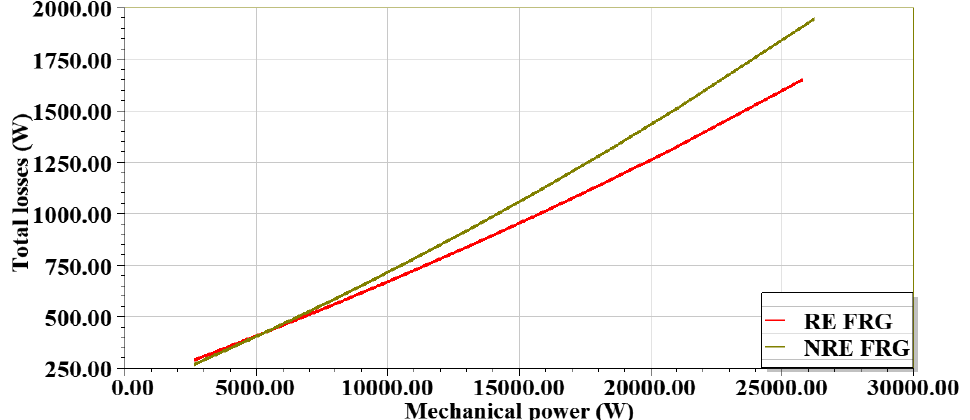
Figure 9. Input mechanical power against total losses comparison at 375 r/min.